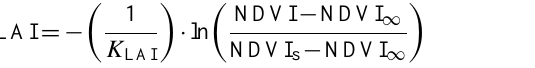
Figure 2. Combination between 3 spectral bands (G, R, NIR) of FORMOSAT-2 images for 3 Fig. 2. Combination between 3 spectral bands ( G , R , NIR) of Fig. 2. Combination between 3 spectral bands ( G , R , NIR) of FORMOSAT-2 images for 3 consecutive dates consecutive dates in July acquired over a small area (2x2km) of the Crau region, showing the FORMOSAT-2 images for 3 consecutive dates in July acquired over in July acquired over a small area (2 × 2km) of the Crau region, showing the mowing of grasslands (in red): the mowing of grasslands (in red): the ‘c’ field was the last mowed. a small area (2 × 2km) of the Crau region, showing the mowing of “c” field was the last mowed. grasslands (in red): the “c” field was the last